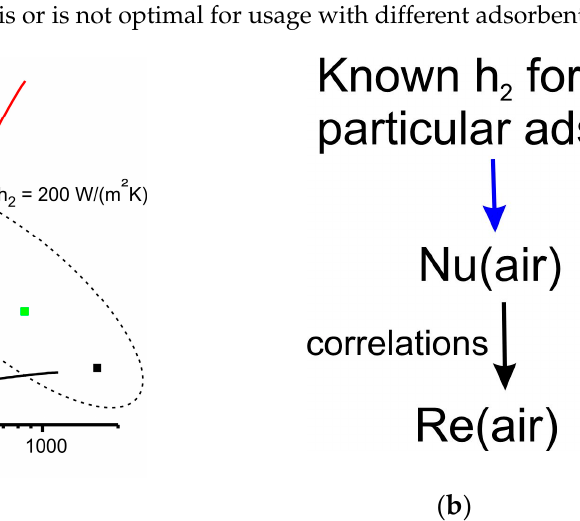
Figure 11. ( a ) Global heat transfer coefficients UA for radiators vs. air Re number (lines) and appropriate UA calculated for different h 2 values. Open symbols—h 2 = 75 W/(m 2 K), solid symbols h 2 = 200 W/(m 2 K); ( b ) Algorithm for estimation of UA for different sorbents.